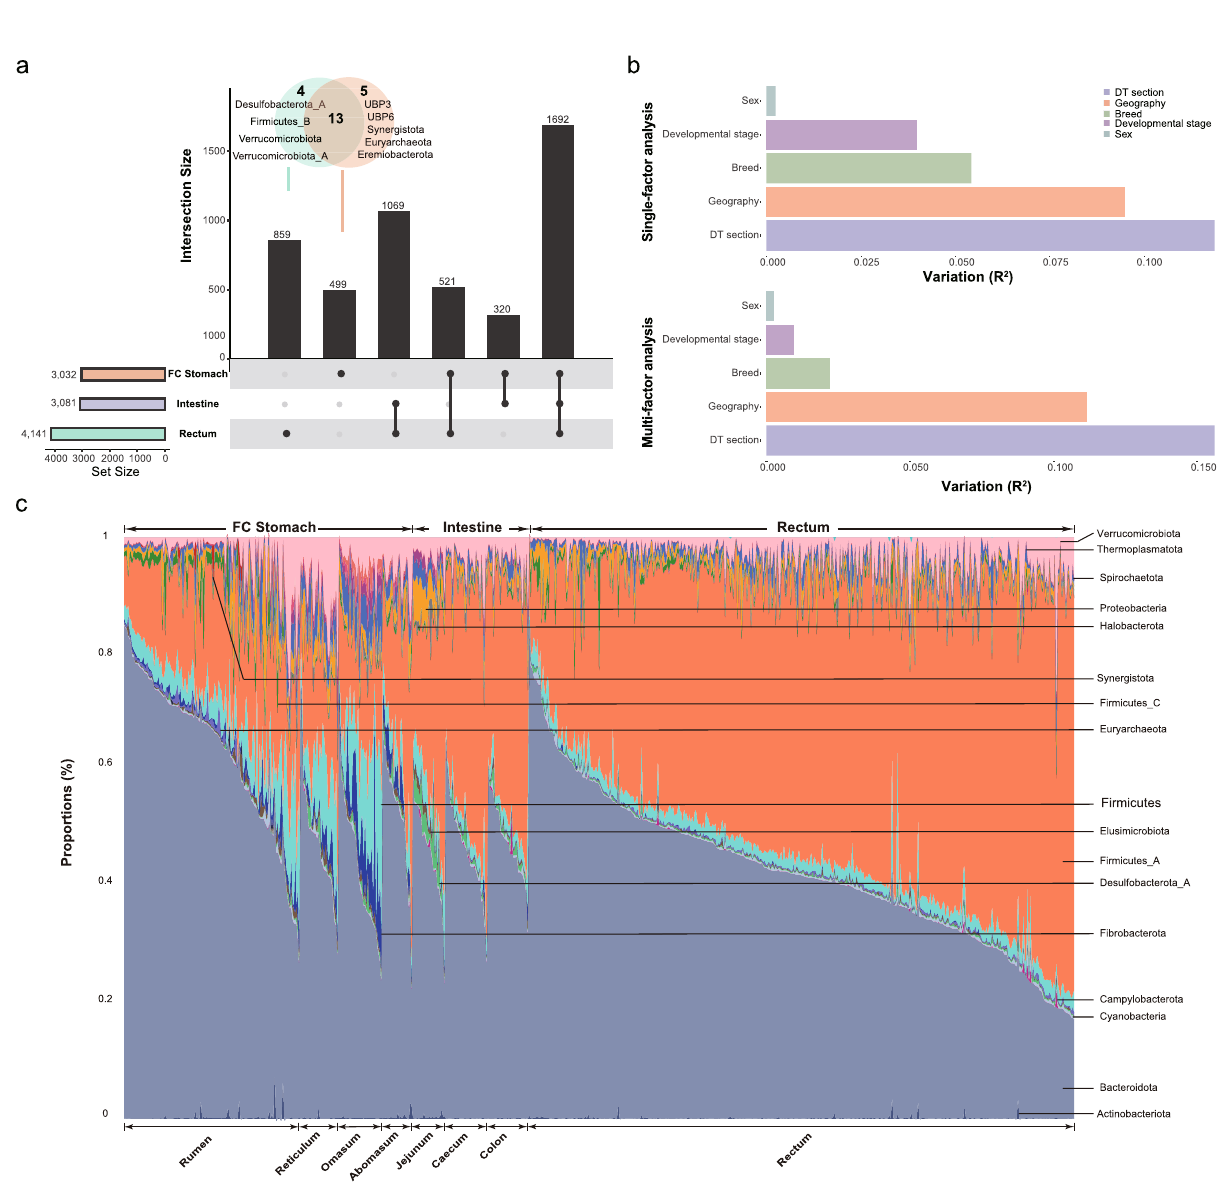
Fig. 3 Taxonomic characterization of buffalo MAGs along the digestive tract (DT). a Distributions of MAGs in different sections along the DT. Here, a MAG is considered to be present in a section if its coverage is greater than 1 × in more than one sample from section. The coverage is de fi ned as the total bases mapped to a MAG in a sample divided by its length. b Bar plot summarizing permutational multivariate analysis of variance (PERMANOVA) analyses results using single and multiple factors. All factors were found to be signi fi cantly associated with gut microbial variations ( P = 0.001). The variations were derived from between-sample weighted UniFrac distances. The pairwise Wilcoxon rank-sum test was used to compare groups. The bars are coloured according to metadata categories. c Stream graph displaying of phyla along the buffalo DT. The X -axis indicates the samples clustered by the sampling sites along the DT. The Y -axis indicates the relative abundances of the phyla in each